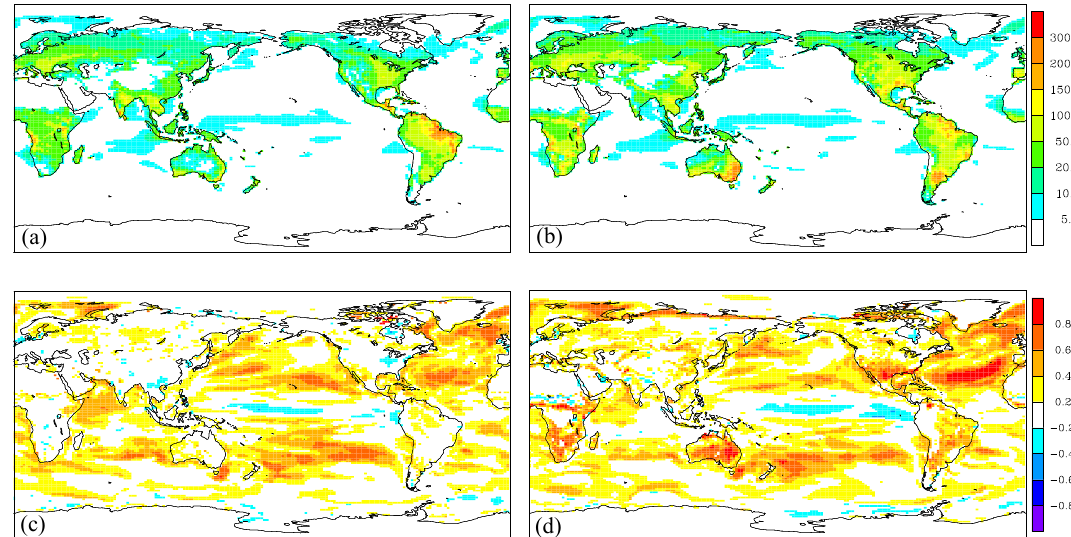
Figure 12. Standard deviation of carbon flux to the atmosphere (a, b) in gCm − 2 yr − 1 for years 901–1000 and the autocorrelation for carbon flux with 1-year lag (c, d) for PresLAI (left) and ProgLAI (right).